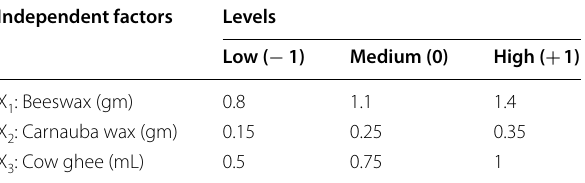
Table 1 Variables in the experimental design Independent factors Levels